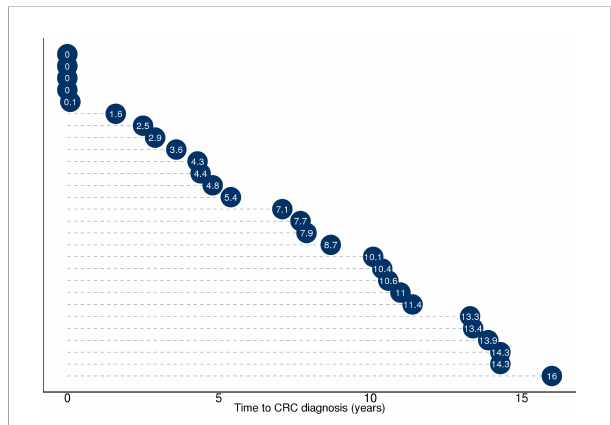
FIGURE 2 Illustration of time from sample collection to diagnosis (in years) for the 28 participants who received a CRC diagnosis during screening or 17 years of follow-up. Full diagnosis and cancer history was retrieved from the Cancer Registry of Norway and included the ICD- 10 coded diagnosis C18, C19, and C20. Five participants with time to diagnosis ≤ 1 year received the diagnosis during screening. Twenty- three study participants received a CRC diagnosis during follow-up ≥ 1